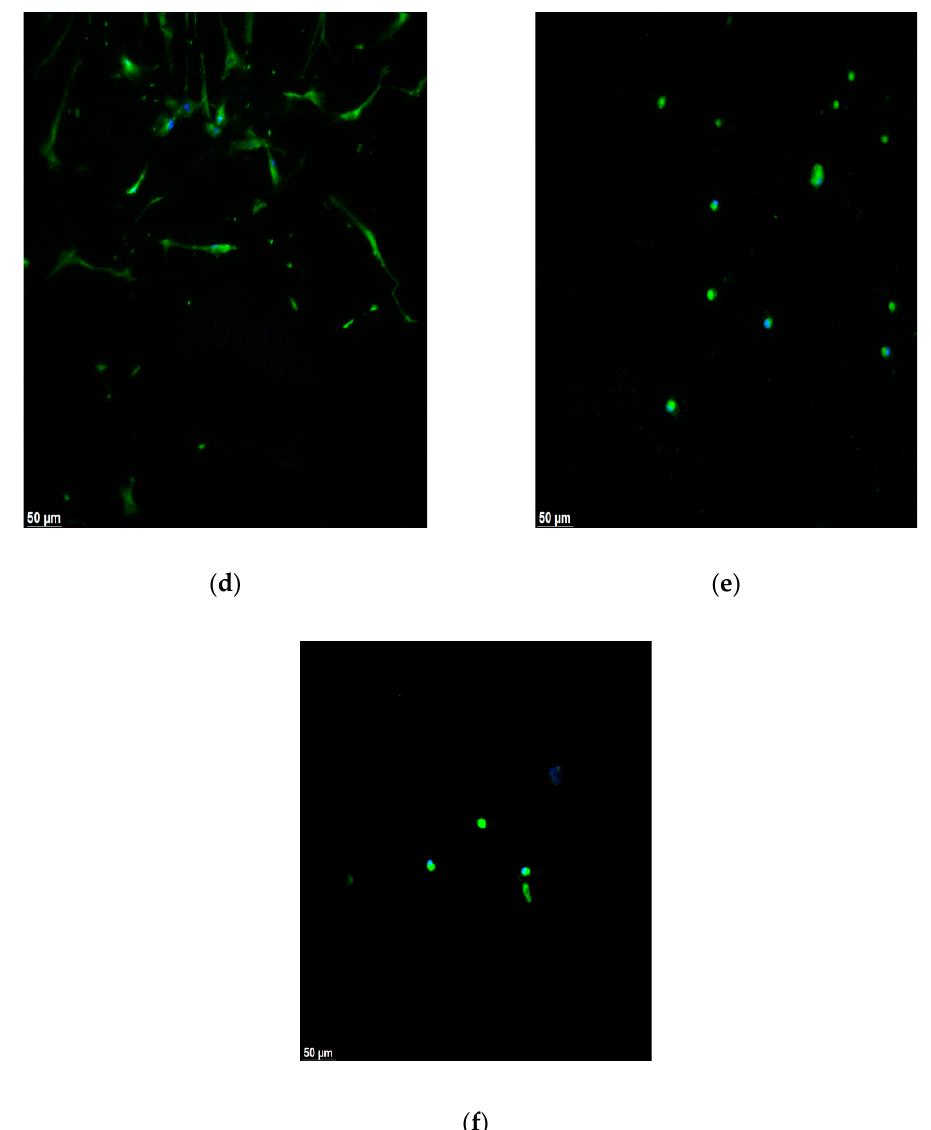
Figure 1. Barrier function test with 20X magnification under confocal microscopy. ( a ) All collagen membranes demonstrated the ability to impede cell migration, and there were no statistically significant differences between the membranes. Following the loading of HGF on membrane surfaces, the base of positive control PET membrane ( b ) displayed high quantities of penetrated HGF, whereas the base of negative control PET membrane ( c ), Jason membrane ( d ), GENOSS Collagen membrane ( e ) and BioMend Extend membrane ( f ) displayed very few penetrated HGF.